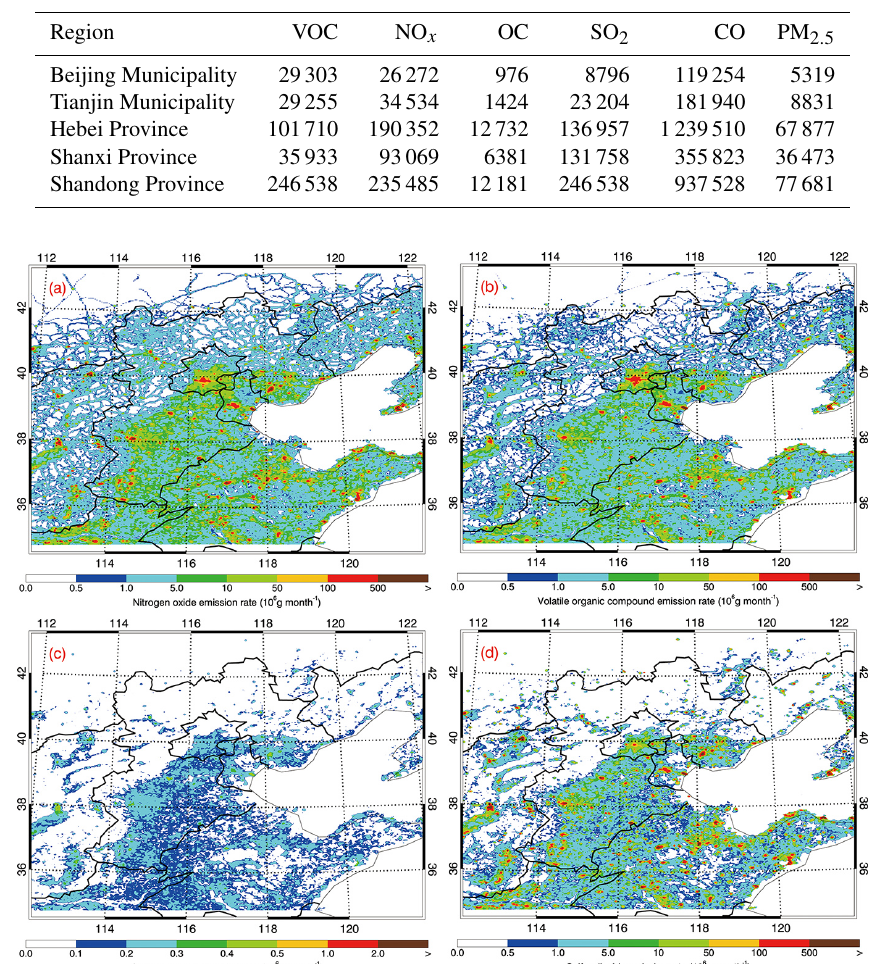
Figure 2. Spatial distribution of anthropogenic (a) NO x , (b) VOC s , (c) OC, and (d) SO 2 emission rates (gmonth − 1 ) in the simulation